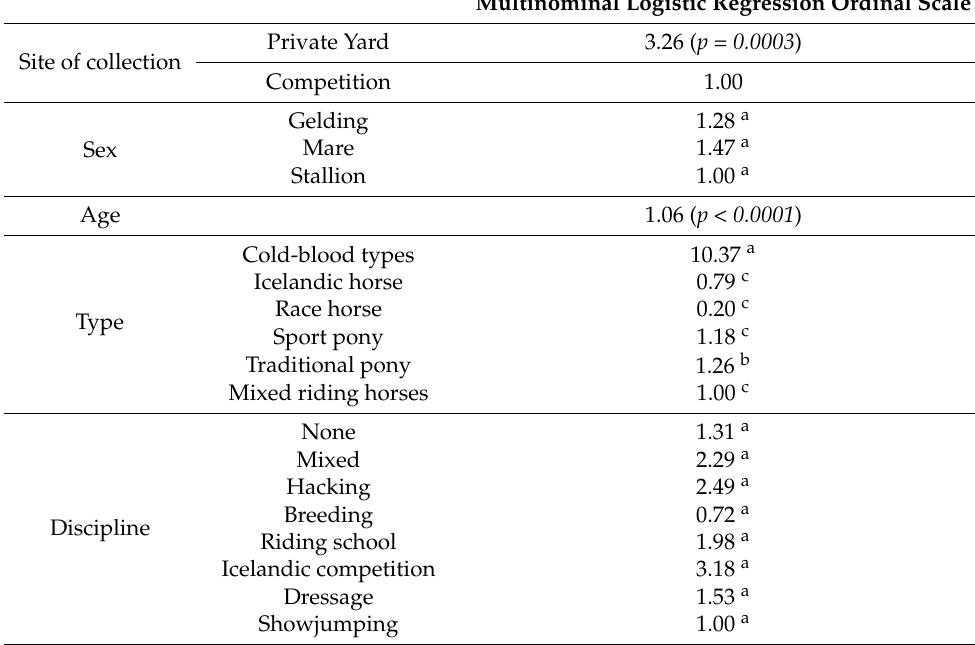
Table 3. Odds ratio for multinominal logistic regression, ordinal scale. A p -value < 0.05 indicates significance between BCS and a parameter. For ORs, group a group b and group c are different. Odds ratio < 1 shows a decreased risk, odds ratio > 1 shows an increased